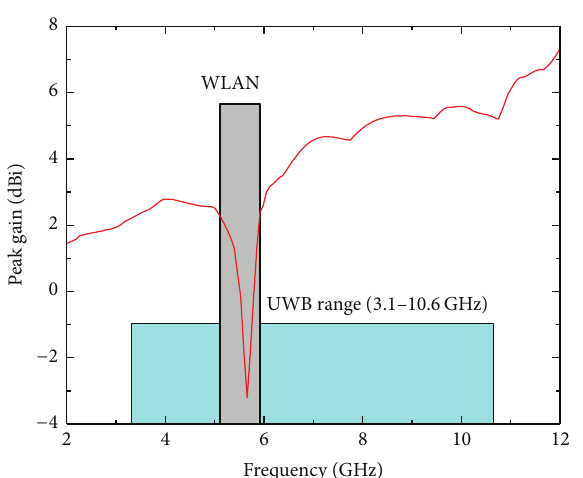
Figure 10: Simulated peak gain of the single UWB antenna inte- grated EBGs.